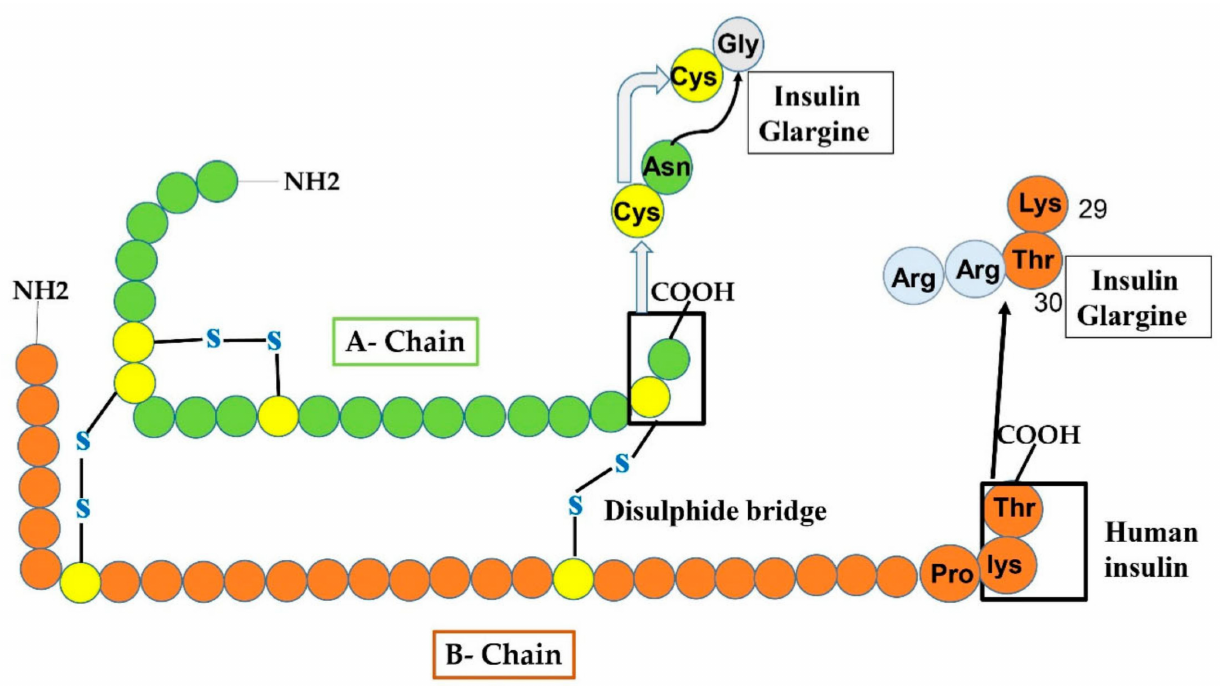
Figure 5. Manifests the production of insulin glargine from human insulin by amino-acids replace- ment at both A and B-chain. At A-chain, in the carboxy-terminal, Gly residue replaced the Asn residue at 21-site shown by an arrowhead. While at B-chain, two additional Arg amino acids are